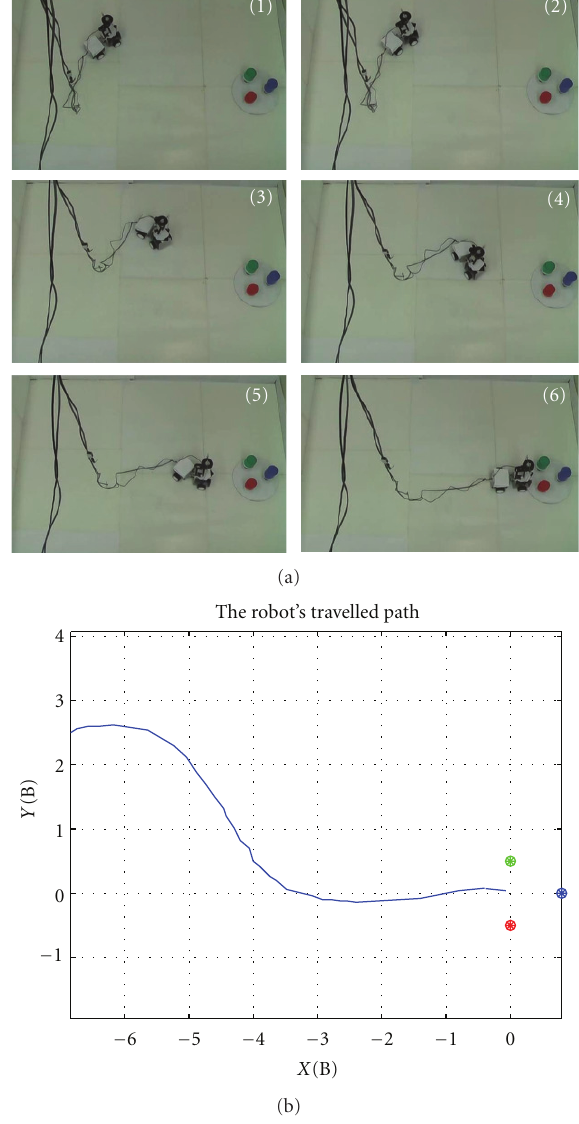
Figure 16: The robot is initially positioned at (7.5, π /8, π /4, 0), (a) the snapshots of the experiment, (b) the traveled path of the